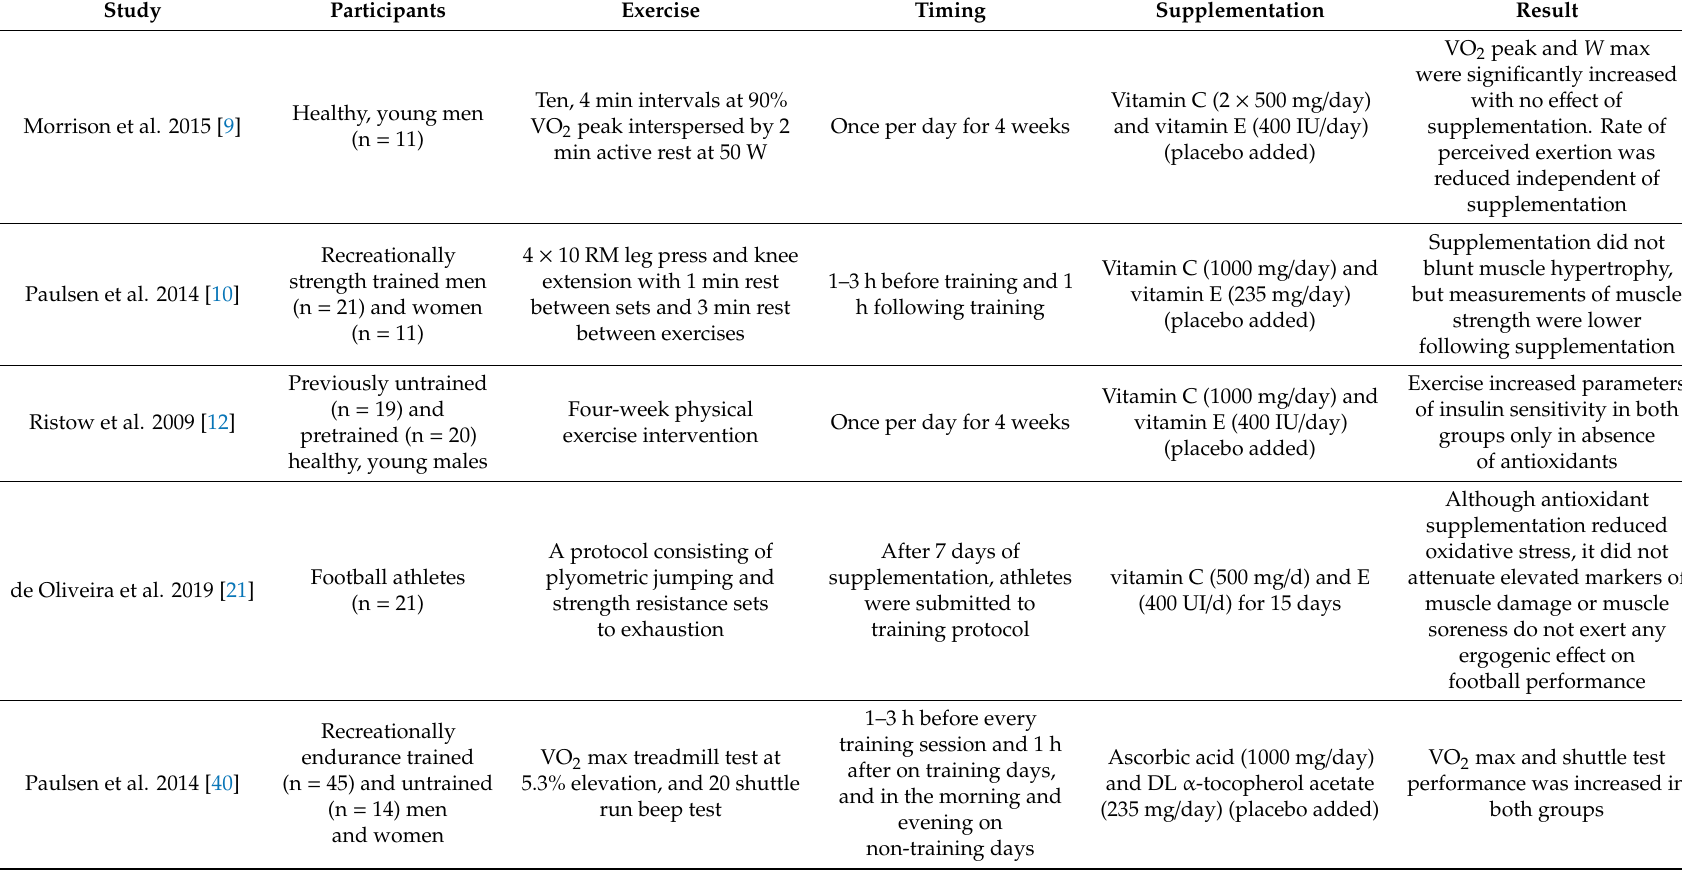
Table 1. E ff ects of vitamin E supplementation, with or without vitamin C, on exercise